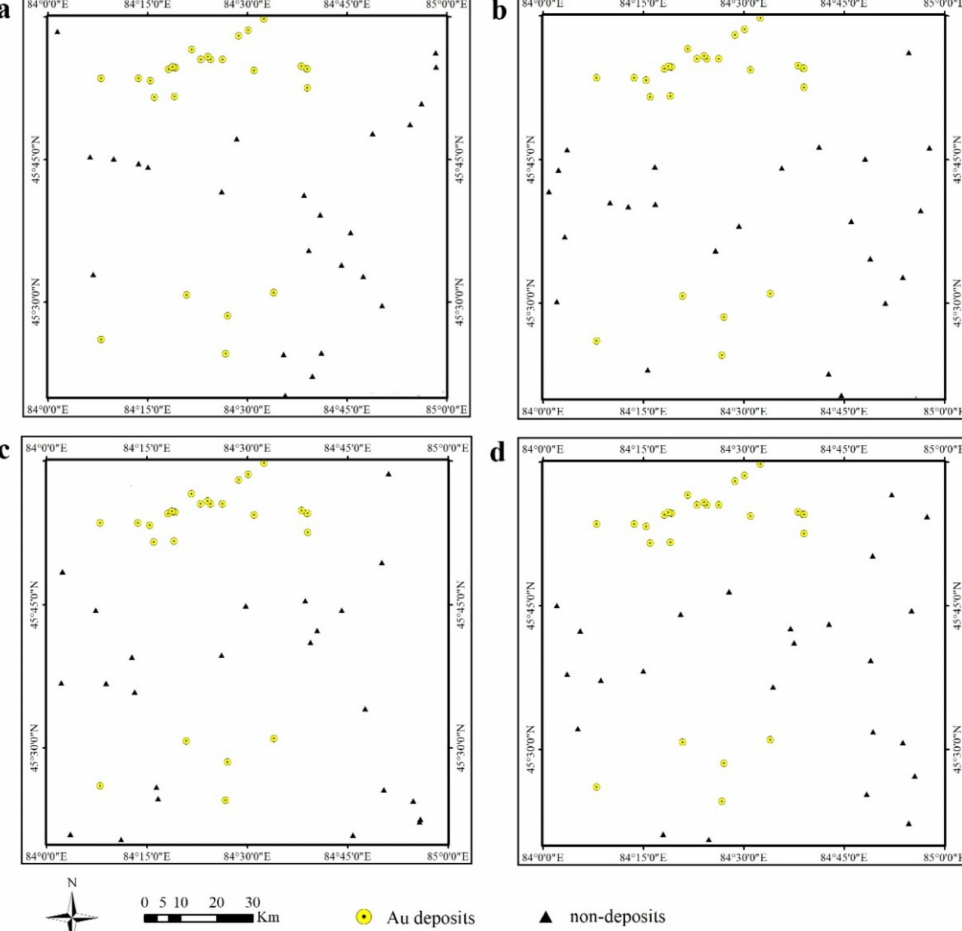
Figure 5. Maps show the locations of four training datasets: ( a ) training dataset 1; ( b ) training dataset 2; ( c ) training dataset 3; ( d ) training dataset 4.